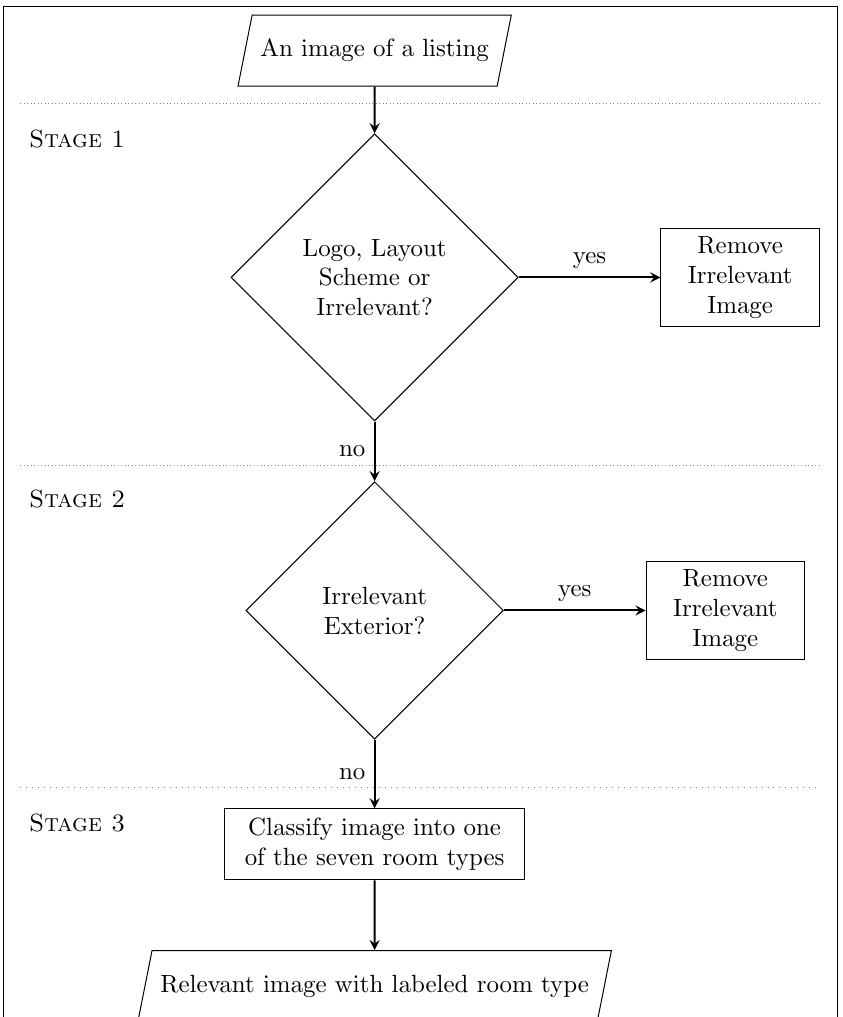
Figure 1. Three stages of image processing for SRED.